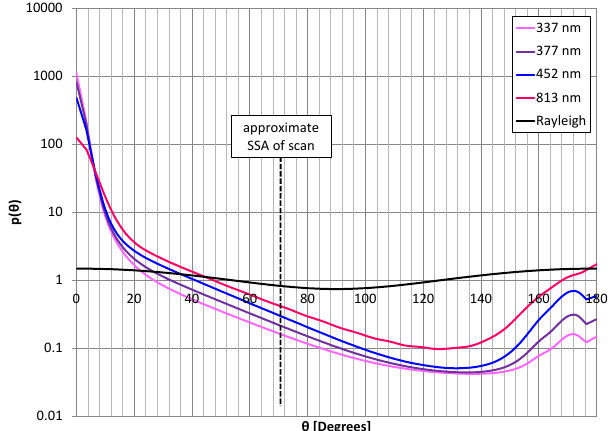
Fig. 5. SASKTRAN-calculated Mie phase functions for absorbing dust (D1) with a log-normal particle size distribution ( r = 1.0µm, σ = 1 . 6µm). The Solar Scattering Angle (SSA) of the two scans in our study is also shown. At SSA ∼ 68 ◦ the 813nm phase function for non-absorbing dust (D2, not shown) is close to that of D1 and does not vary appreciably towards 337nm. Rayleigh side-scattering from O 2 and N 2 molecules is greater for the full range of OSIRIS observation scattering angles ( ∼ 60 ◦ < SSA < ∼ 120 ◦